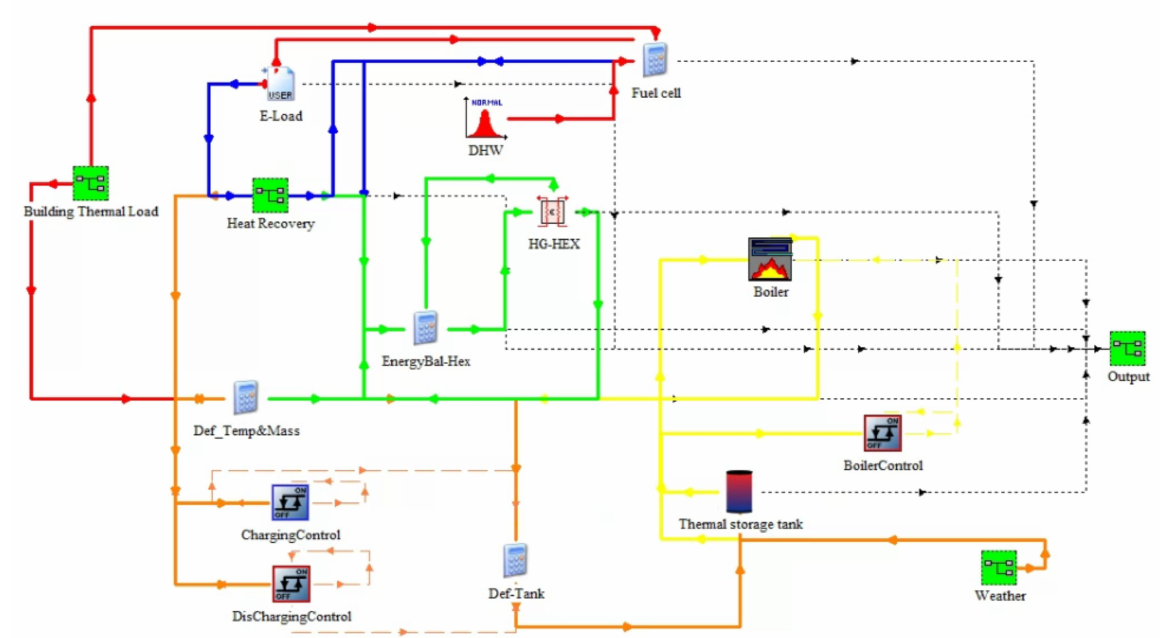
Figure 2. Operating strategy of FC-CHP system.